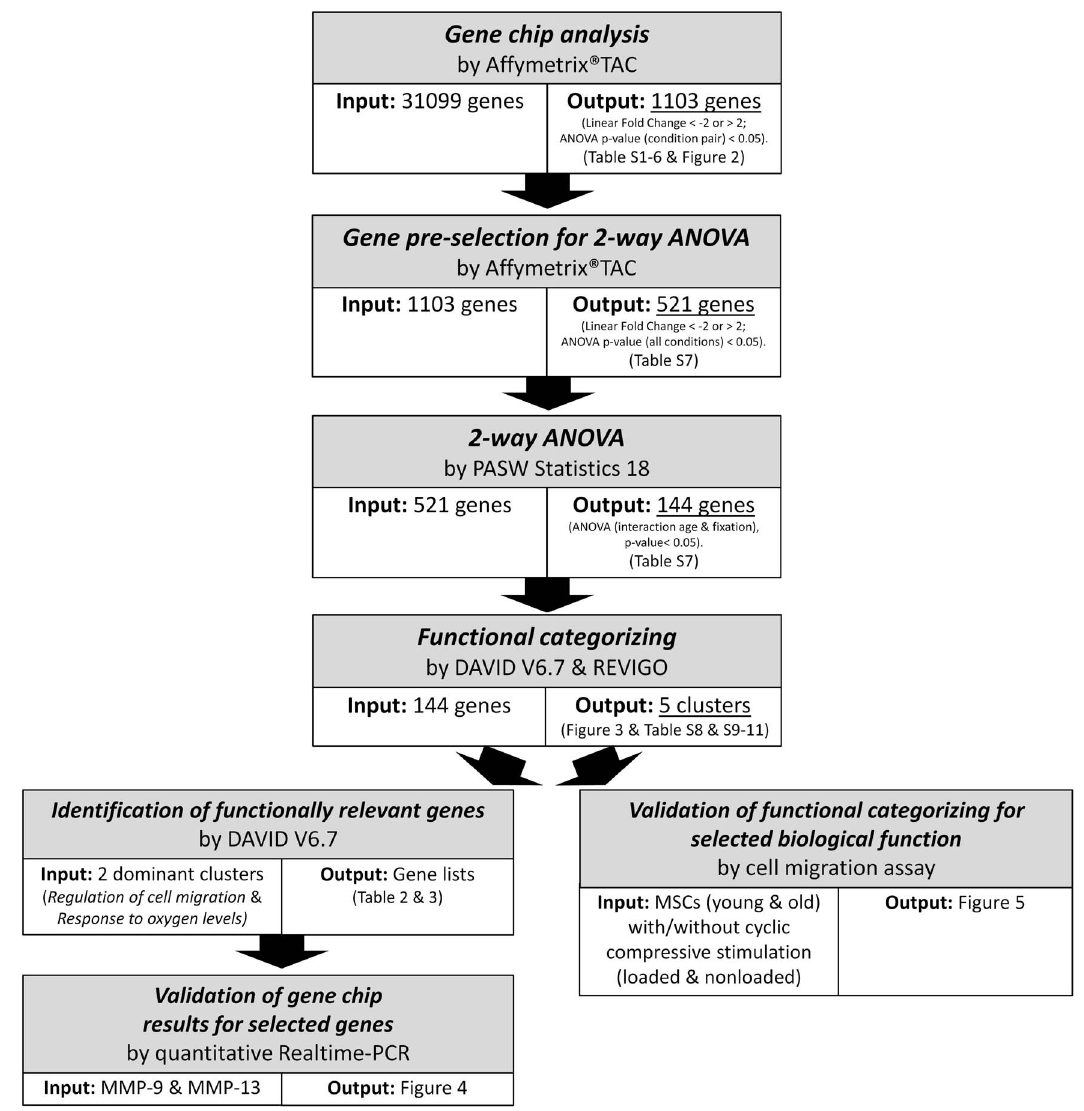
Figure 6. Summary and overview of the work flow in this study.